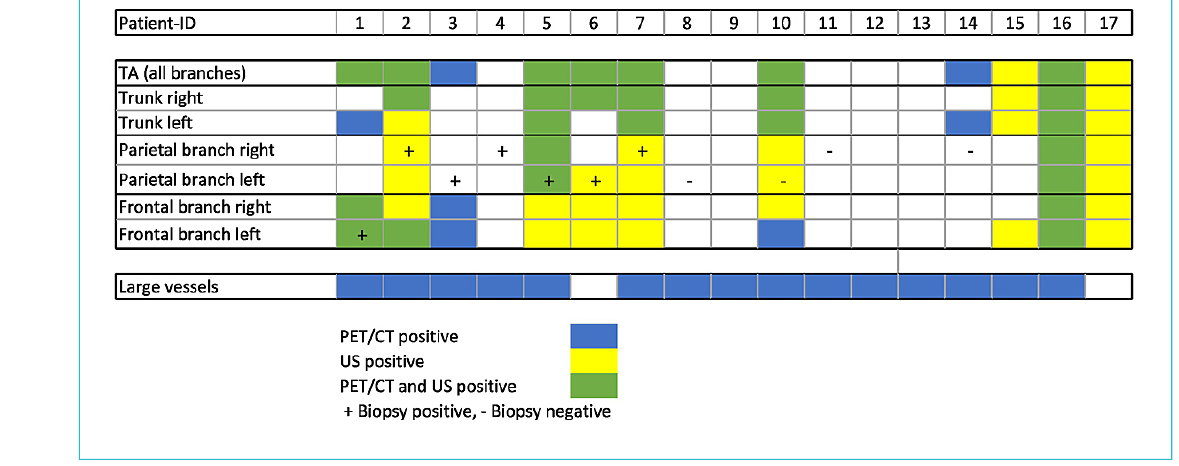
Figure 2: Distribution of positive findings in individual temporal artery (TA) segments for positron emission tomography-computed tomography (PET/CT), ultrasound (US) and temporal artery biopsy in giant cell